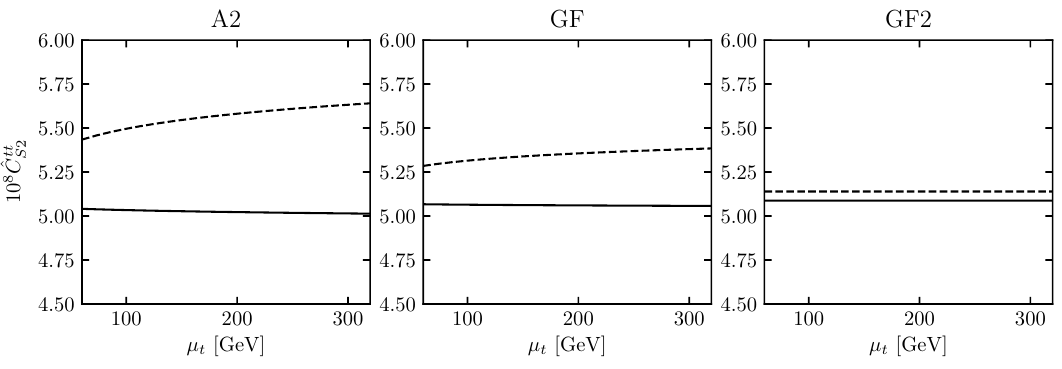
Figure 4 . Residual electroweak matching scale dependence in the full OS scheme. The dashed line shows the LO result, while the solid line show the NLO result. See text for